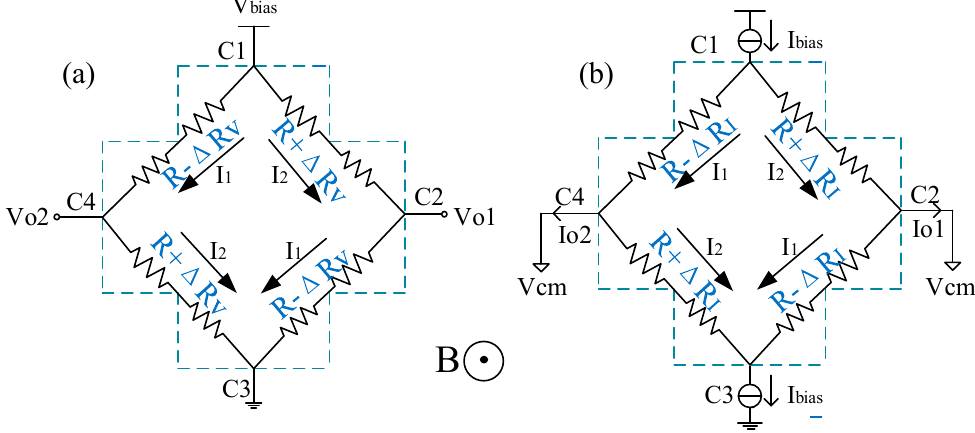
Figure 1. Wheatstone bridge model of the cross-like Hall plate. ( a ) voltage-mode; ( b ) current-mode.